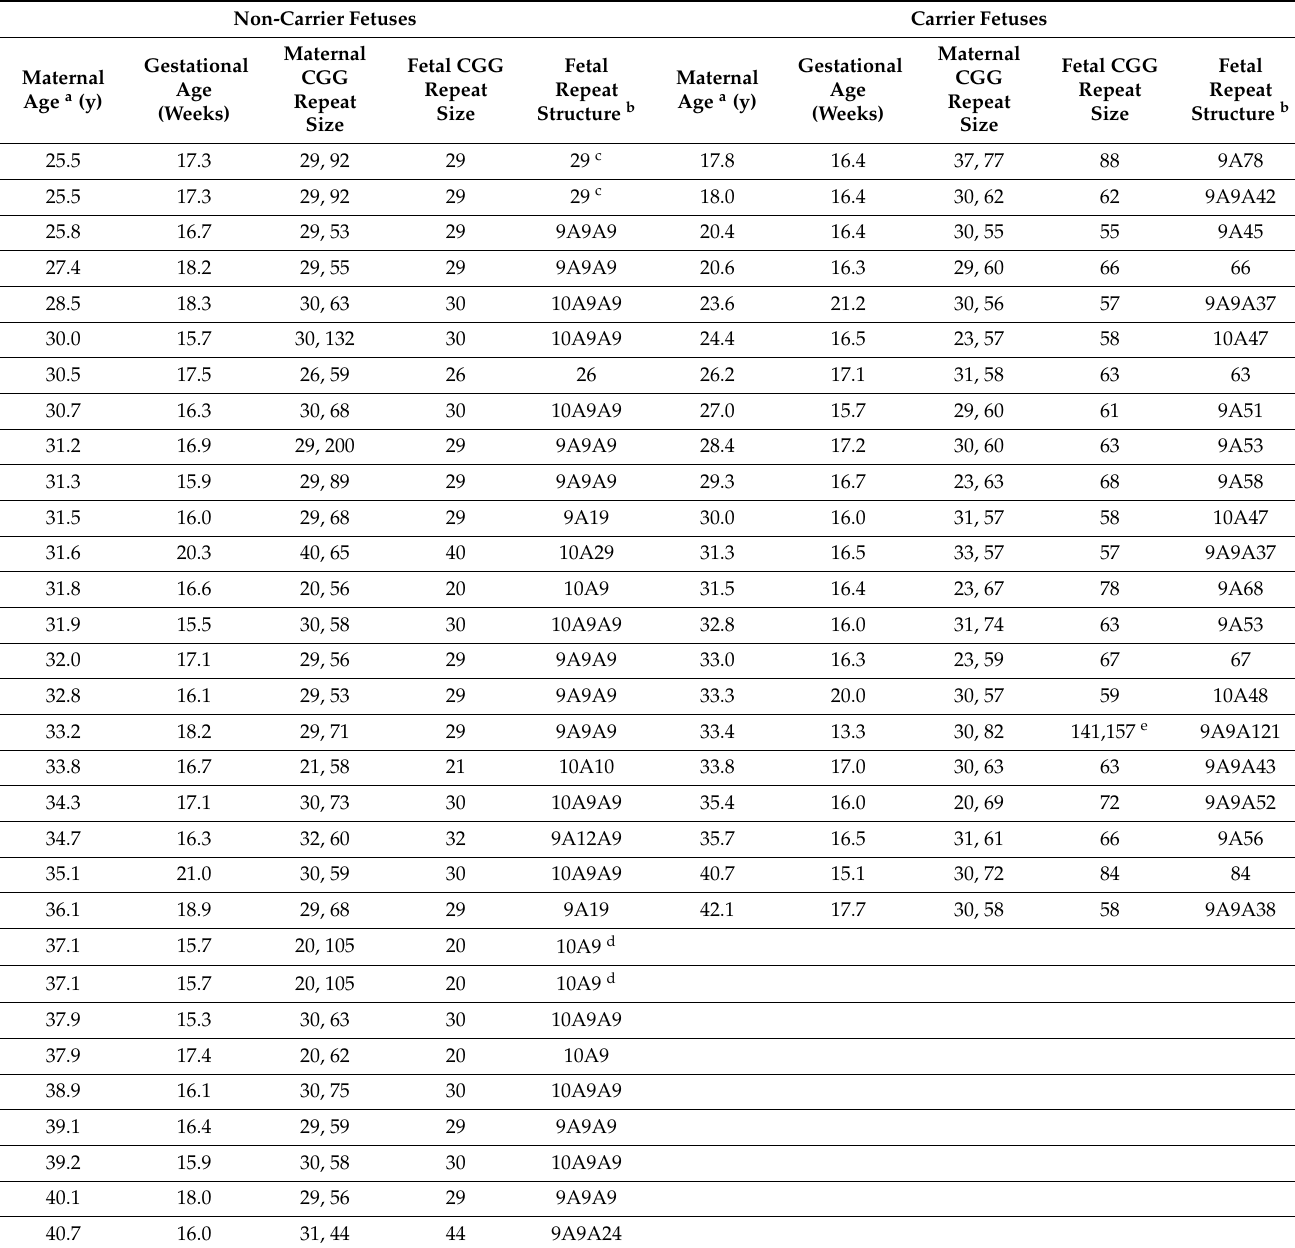
Table 1. Characteristics of the cohort and samples available for this